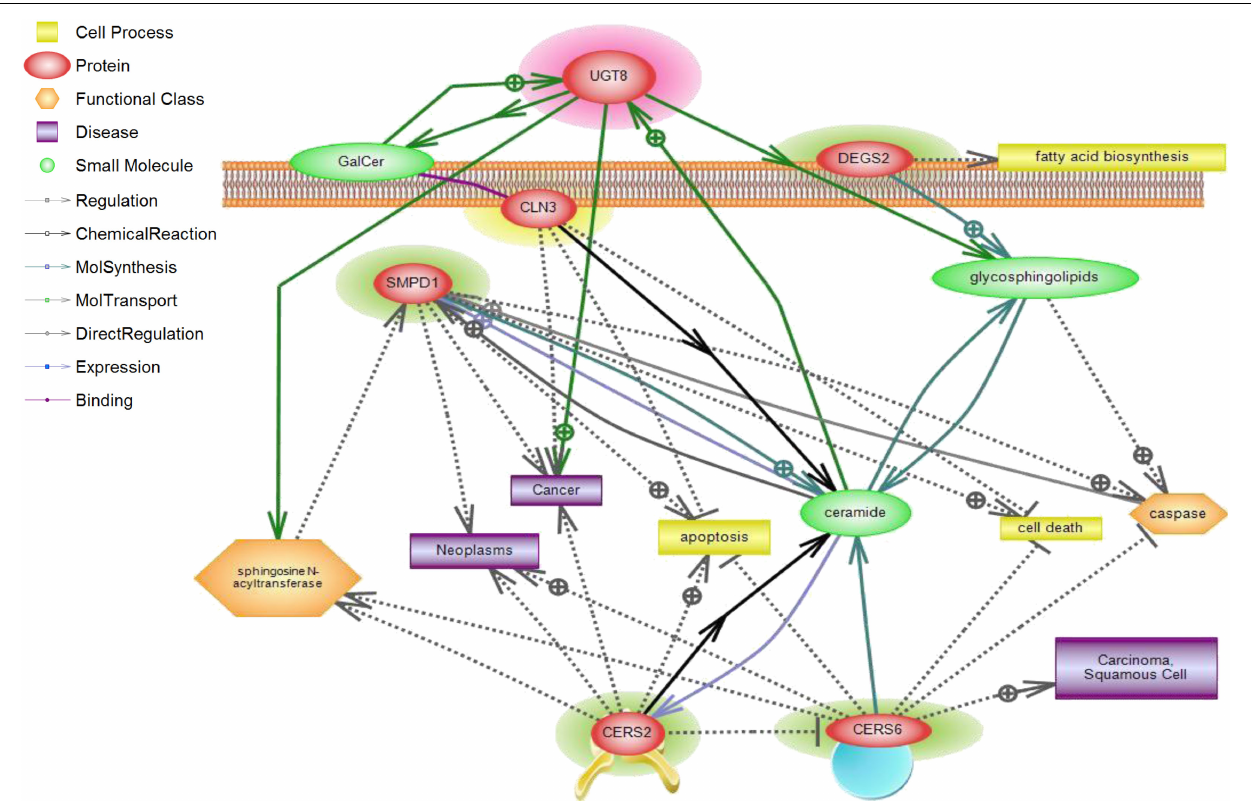
FIGURE 5 | CLN3 and sphingolipid signaling pathway interactions analyzed using Pathway Studio . Pathway Studio analysis was used to create a network of biologically relevant genes involved in sphingolipid metabolism and CLN3 for comparisons in normal vs. tumor samples. The position of the node represents the subcellular localization of the gene product. Lines represent type of relations that were automatically extracted from the literature. A total of five genes were represented in the network, with a number of focus genes with functions relating to sphingolipid metabolism.